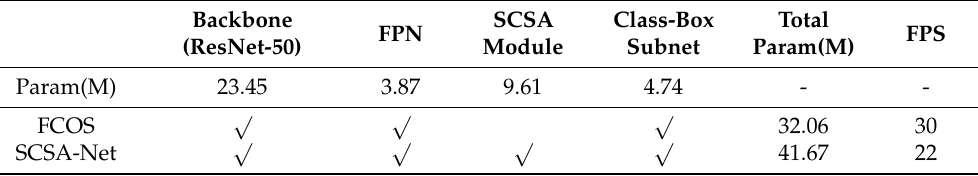
Table 6. The number of parameters of each module and the testing speed of the network.